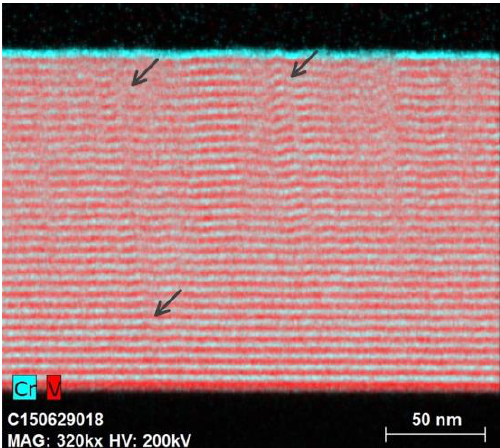
Figure 7. EDX (Energy Dispersive X-Ray Spectroscopy) map of cross section of Cr/V multilayer with d V = 4.0 nm and d Cr = 1.3 nm, where Cr layers are shown in blue and V layers in red. Arrows indicate bumps appeared during multilayer structure growth.